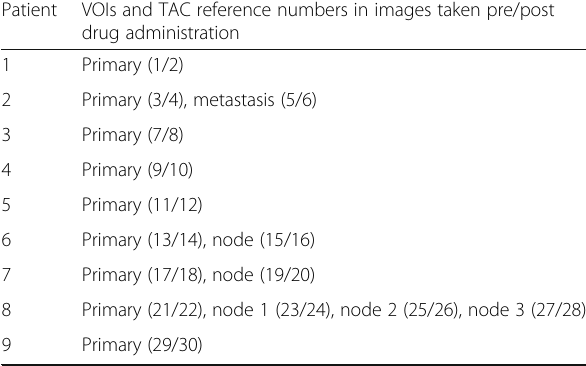
Table 1 Details of the 30 whole tumor TACs analyzed Patient VOIs and TAC reference numbers in images taken pre/post drug administration